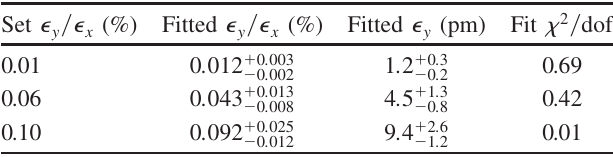
TABLE VI. Results of fits to Touschek parameter data.